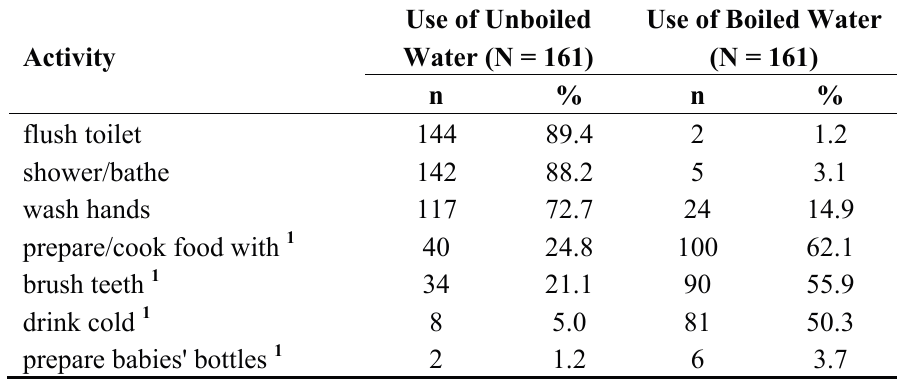
Table 6. Use of unboiled and boiled tap water by routine